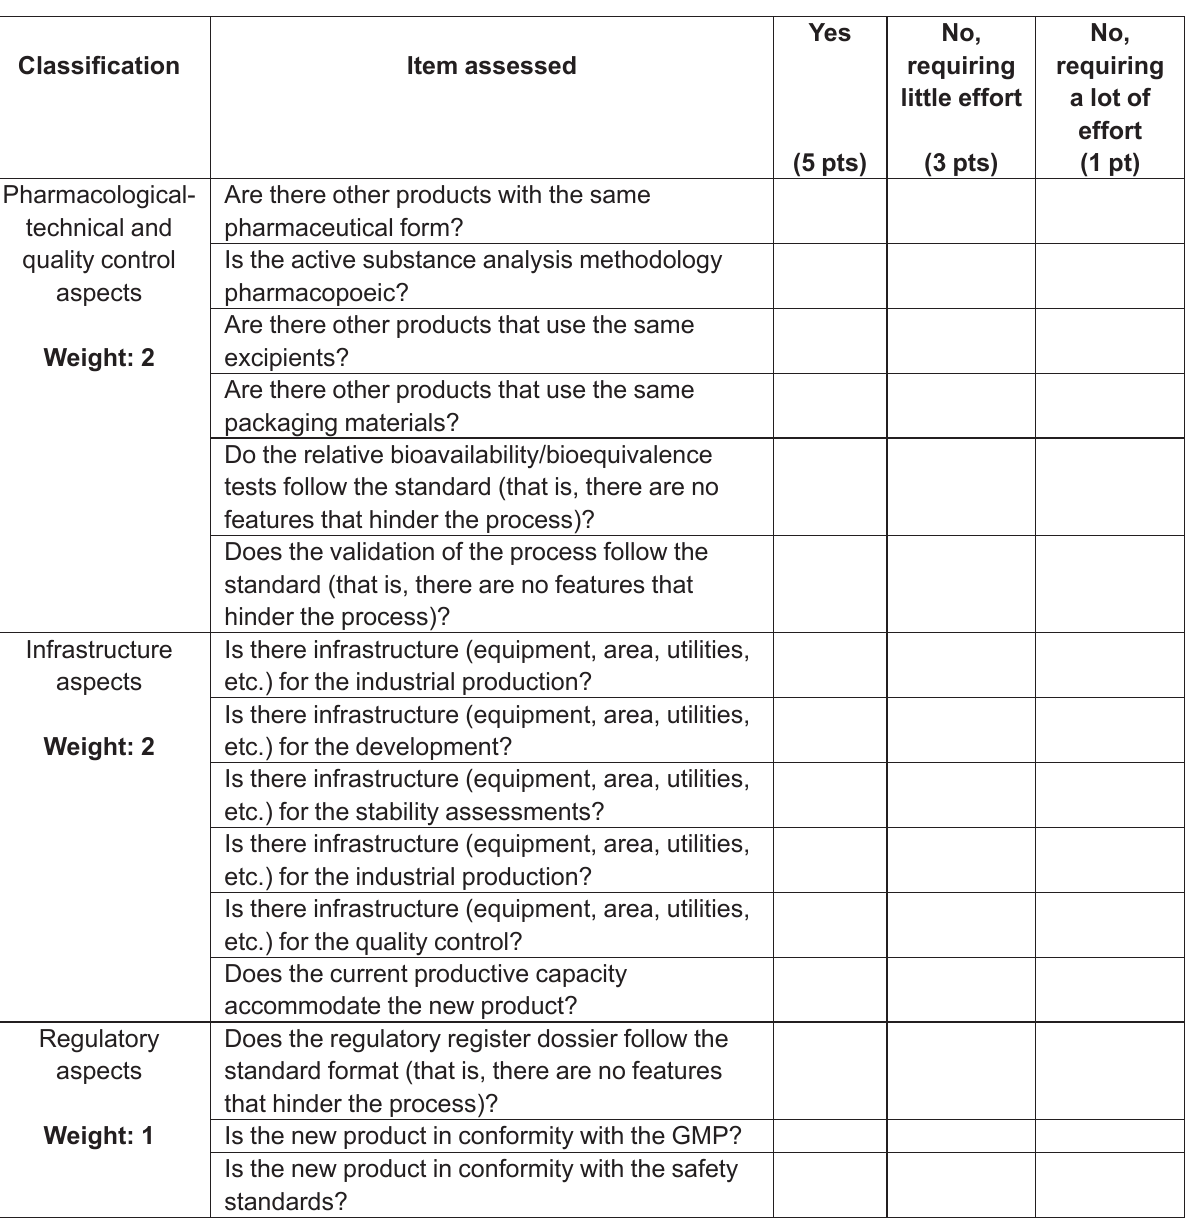
FIGURE 7 – Checklist for evaluation of technical